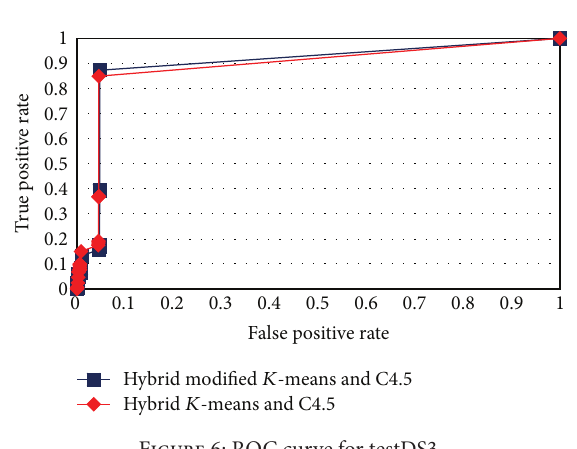
Figure 5: ROC curve for testDS2.